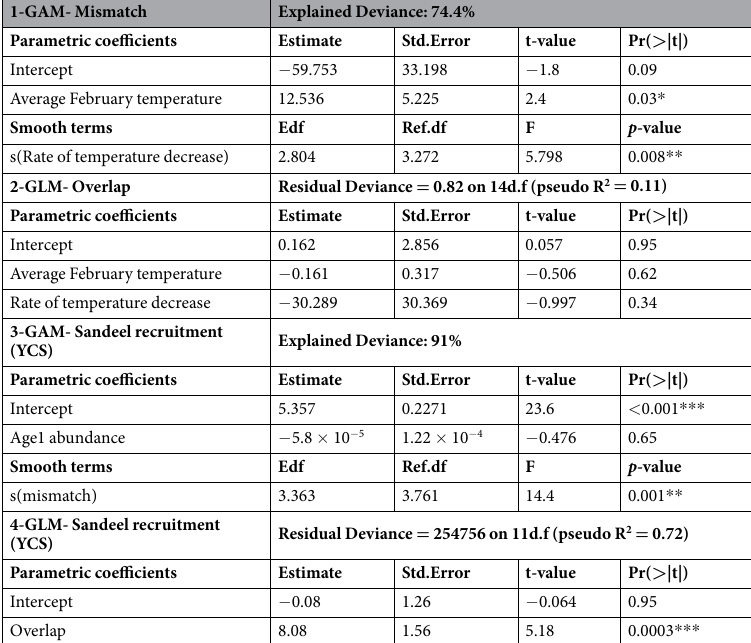
Table 2. Model outputs of the dependence of the mismatch measure, the overlap and the recruitment index (year class strength) on environmental and stock variables.